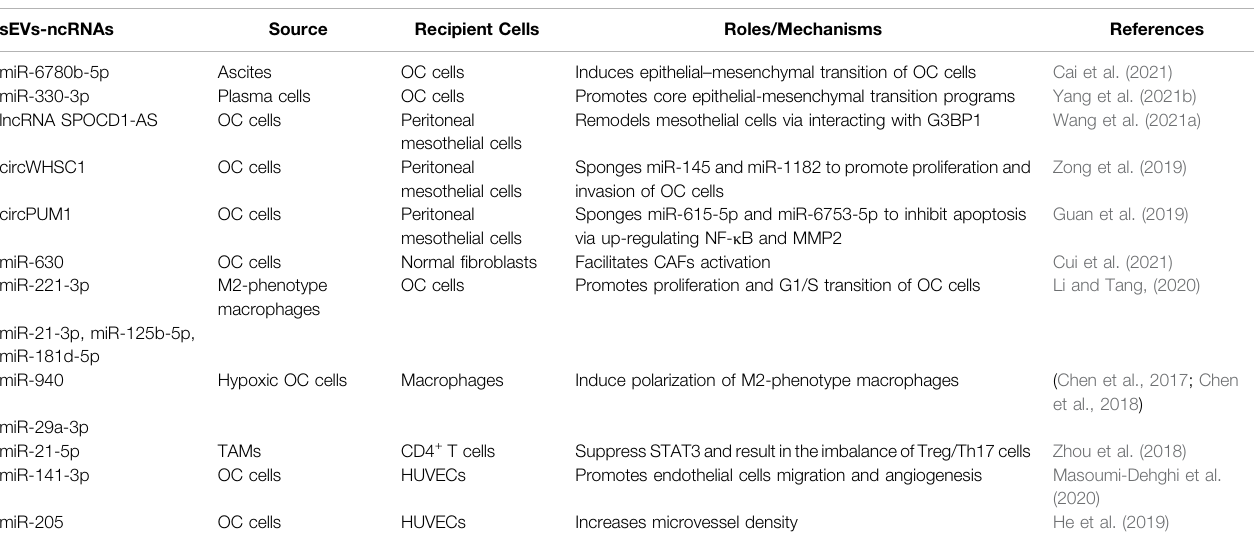
TABLE 1 | Summary of sEVs-ncRNAs involved in OC